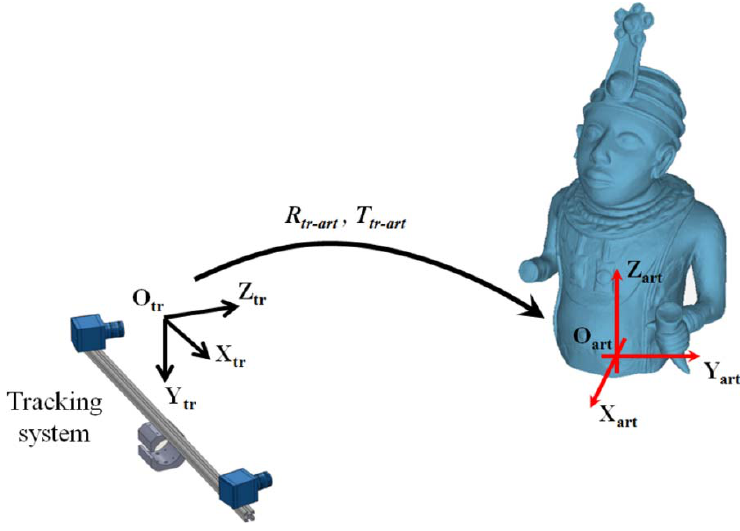
Figure 7. Scheme of the Reference Information System. The rigid motion ( R determined through a calibration